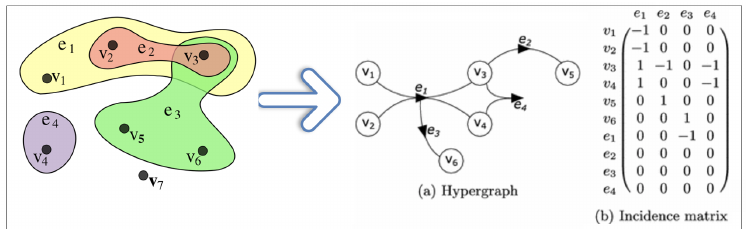
Figure 14. Smith normal